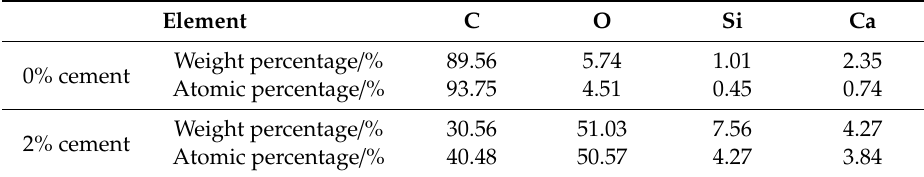
Figure 8. Chemical composition of CRME with 2% cement. Table 4. Chemical composition of CRME with 0% and 2%